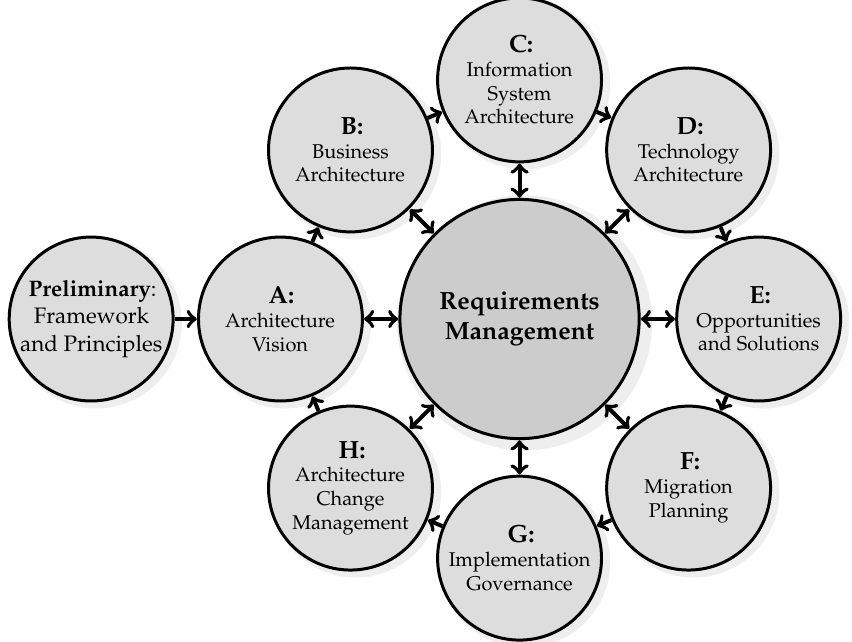
Figure 3. The Open Group Architecture Framework: a logical, cyclic, step-by-step requirements elicitation